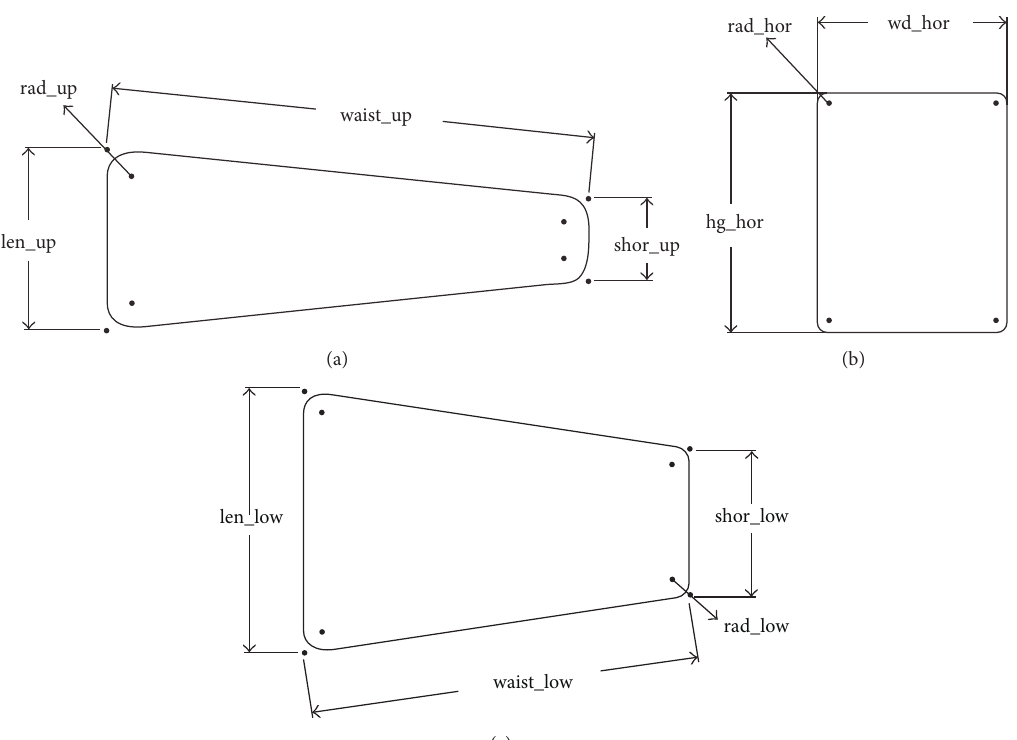
Figure 7: Geometric parameters of port cross sections. (a) Cross section of the upper port; (b) cross section of the equatorial port; (c) cross section of the lower